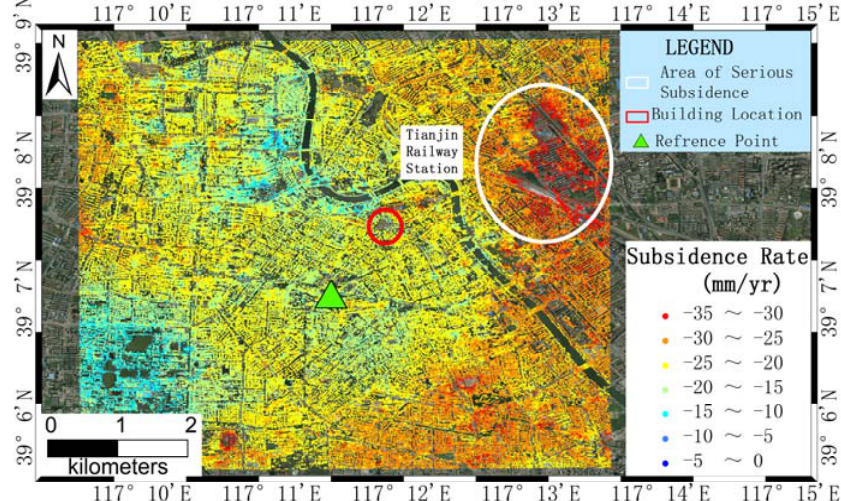
Figure 2. Linear Subsidence velocity with ranges from − 35 to 0 mm/year from Interferometric Point Target Analysis (IPTA)process, the area near Tianjin Railway Station have subsidence more than 30 mm/year, and the location of two selected buildings have subsidence value of approximately − 20 mm/year. The background is aerial ortho ‐ photo of 1 m.